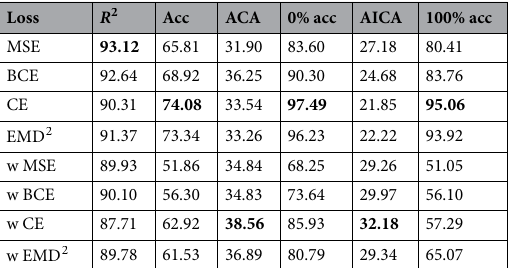
2 Table 1. Test R -scores and accuracy values (in %). w indicates a weighted loss. Best results in bold. ACA: average class accuracy; AICA: average intermediate class